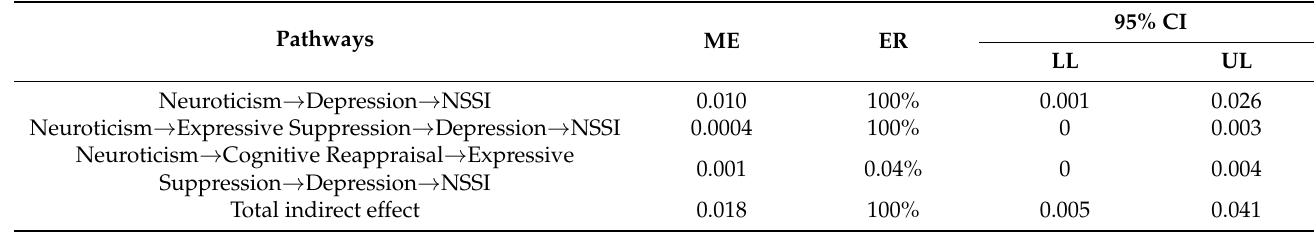
Table 6. Mediation effect analysis of neuroticism, emotion regulation, depression, and NSSI among male college students.